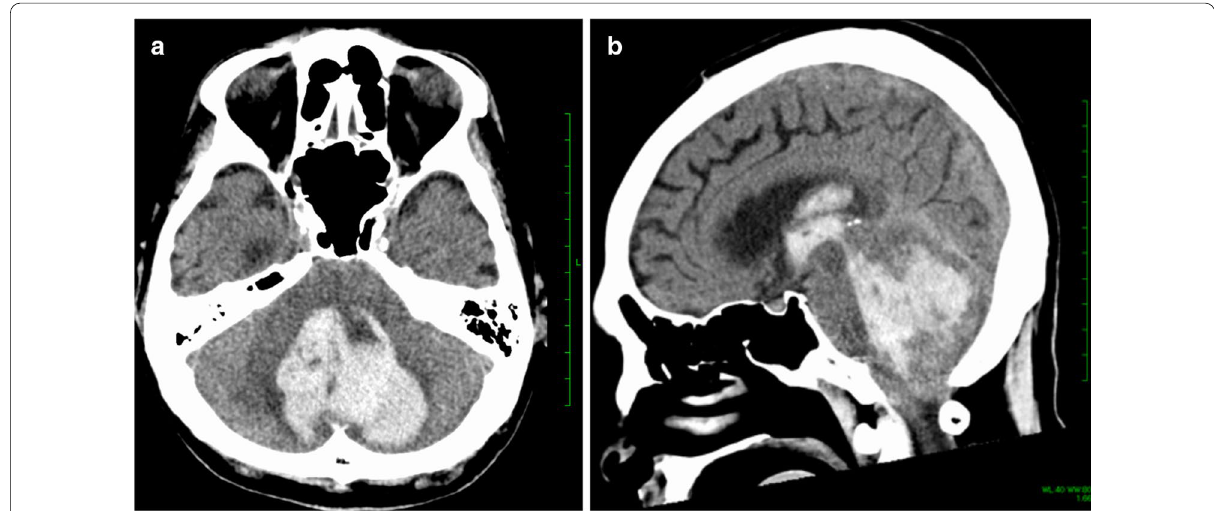
Fig. 4 Brain computed tomography (CT) images of case 2. Cerebellar bleeding with intraventricular rupture was observed on POD